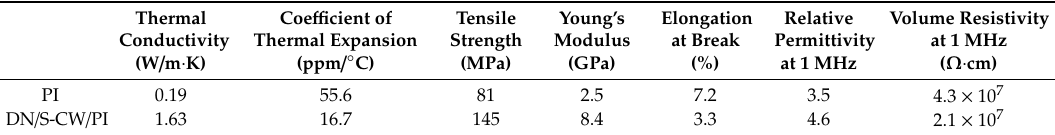
Table 1. The properties of the composite (10 wt% DNs, 7 wt% SCWs) compared with the PI